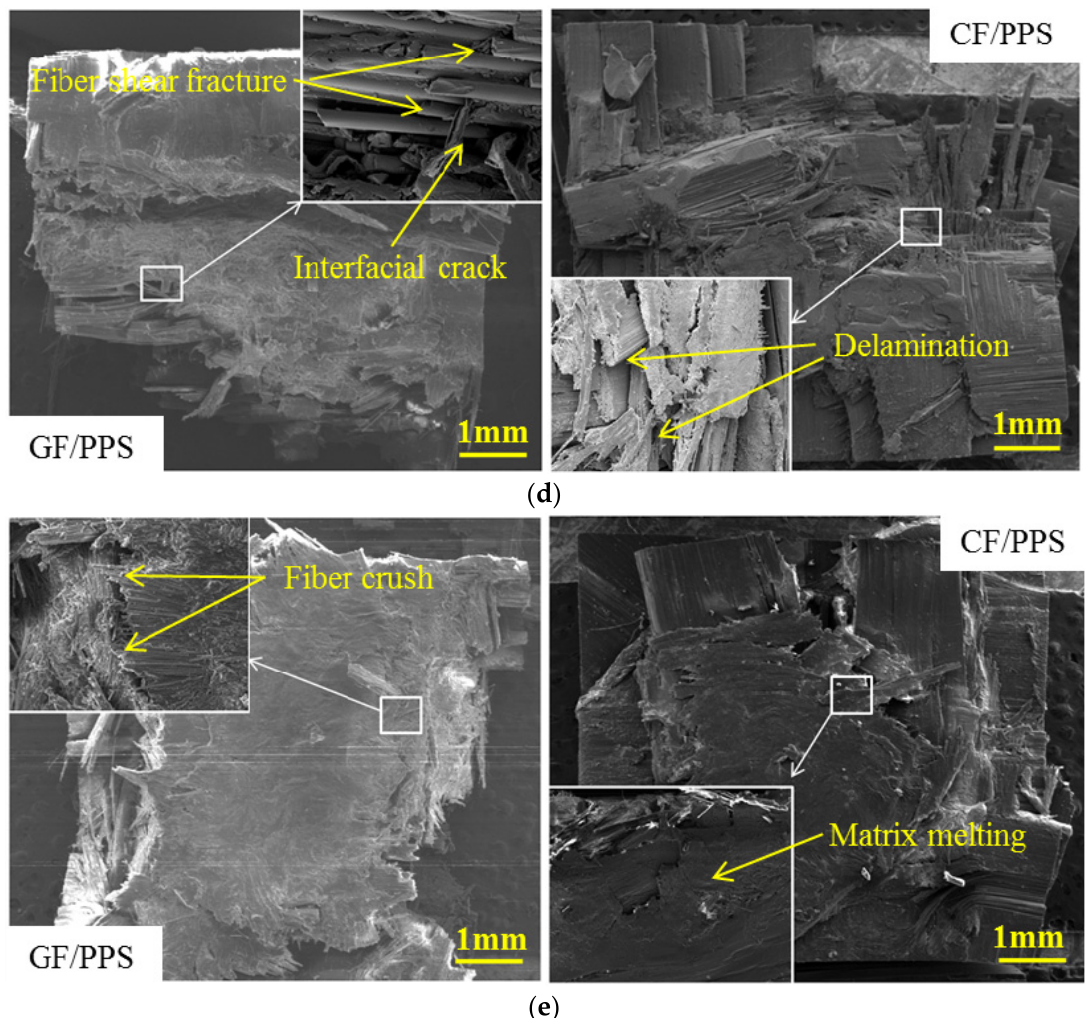
Figure 9. SEM micrographs of GF/PPS and CF/PPS specimens under different strain rates at room temperature: ( a ) 650/s; ( b ) 1450/s; ( c ) 1950/s; ( d ) 2450/s; ( e ) 3500/s.